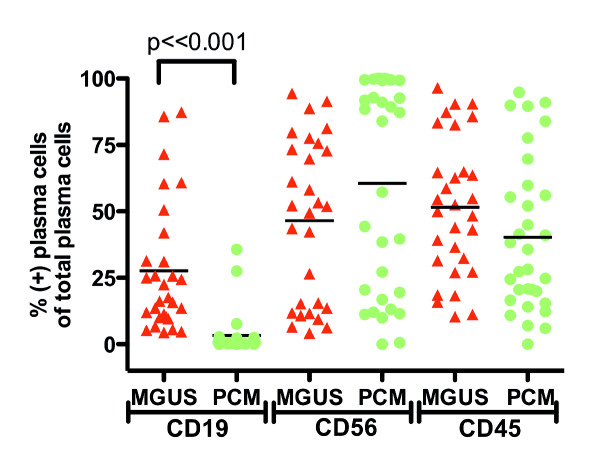
Comparison of normal plasma cell population size in monoclonal gammopathy of undetermined significance (MGUS) and plasma cell myeloma (PCM). MGUS cases (red) have a significantly higher CD19(+) plasma cell population as compared to PCM cases (green). There are no significant differences in CD56 and CD45 expression. Horizontal bars represent mean values.